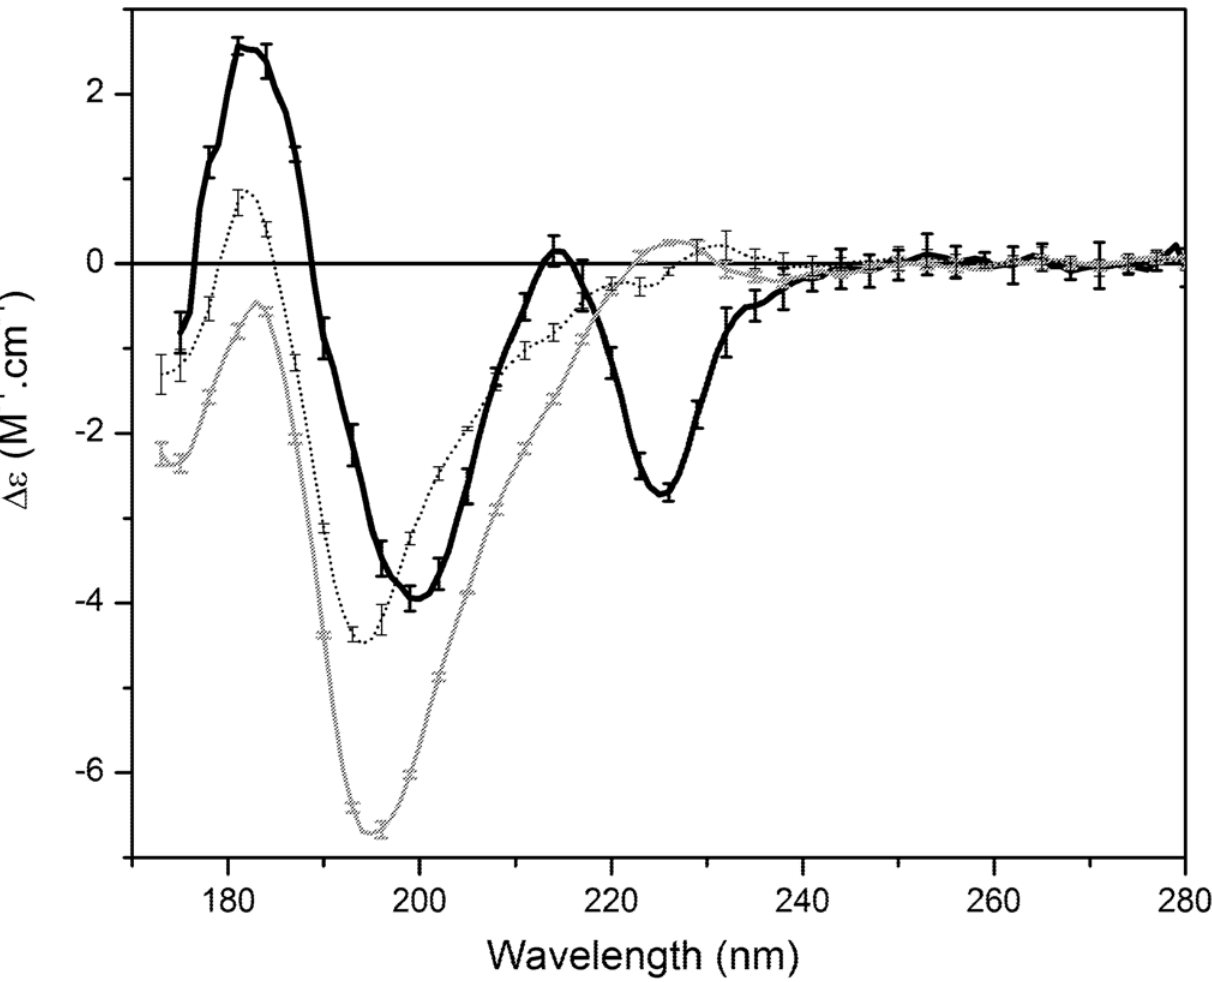
Fig 1. SRCD spectra of DGAT1 peptides. Sit1 (black), Sit2 (grey) and Sit1&2 (dot) in 20 mM Sodium Phosphate buffer (pH 7.0). Error bars represent one standard deviation in the replicate